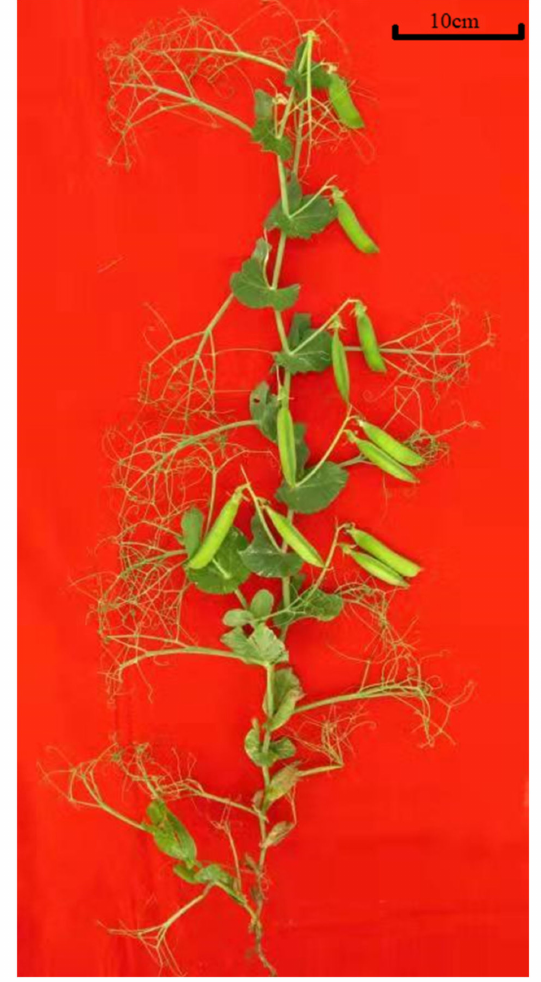
Figure 3. Plant characteristics of Longwan No. 6; the height of Longwan No. 6 ranges from 60.0